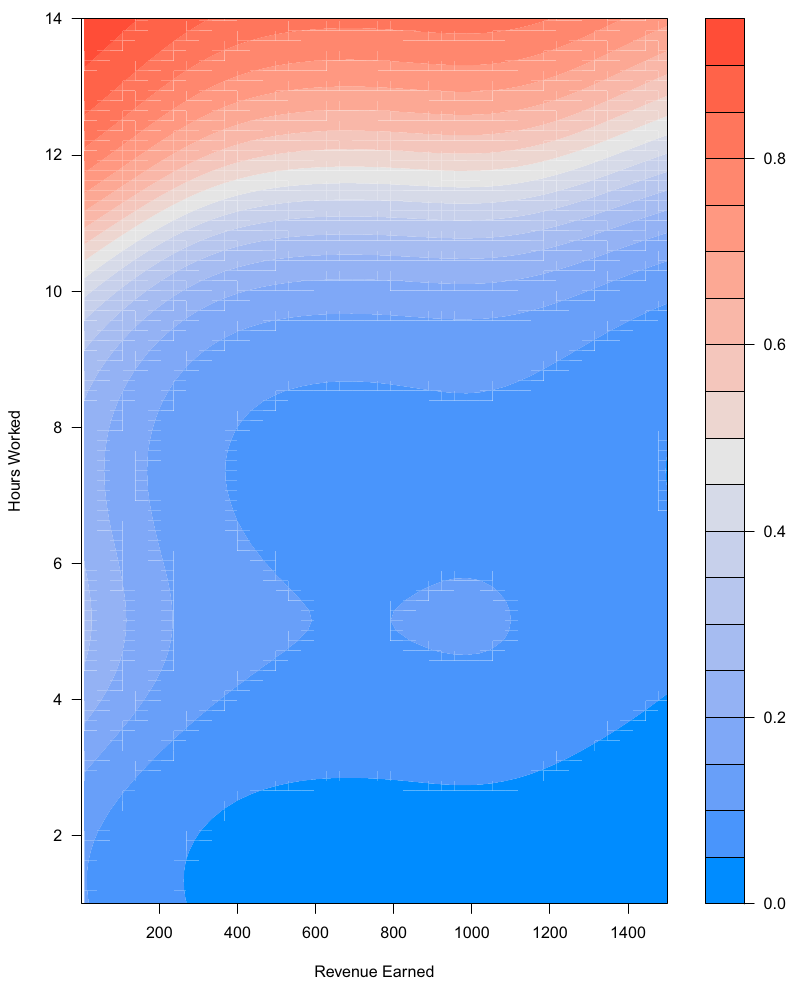
Fig. 3 Heatmap indicating predicted probability of ending the shift in dependence of hours worked and revenues earned. Results were obtained from a strictly non-parametric regression according to the GAM method introduced, but just the time and revenue variable used as predictors (thus excluding all fi xed effects), whereas both were chosen to be smoothed over. Range of data has been chosen based on the number of data points 7.5. E.g. too few data points fall after 1500 ZAR earned. Source: Own representation, Data: GoMetro